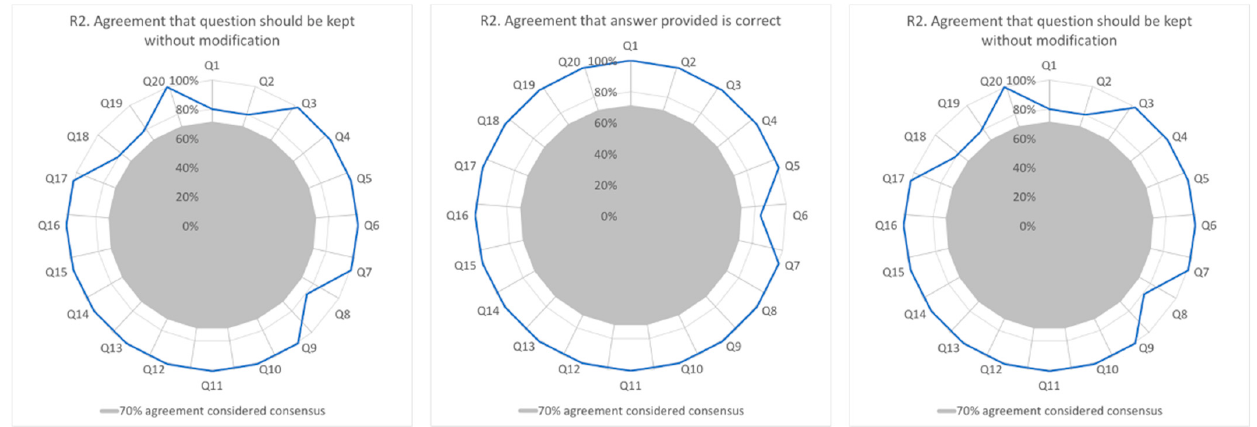
Figure 2. Delphi Round 2 participant responses ( n = 6), in relation to agreement of answer, relevancy, and whether modification is required. Q= question number.